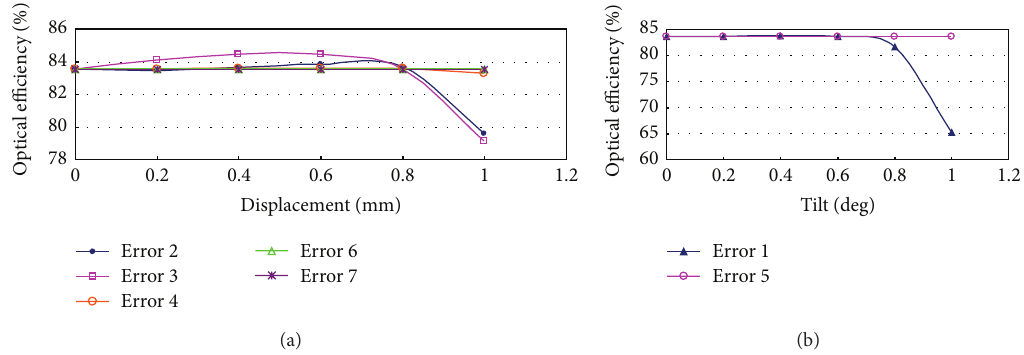
Figure 13: Optical efficiency under different assembly errors: (a) element displacement and (b) element tilt.